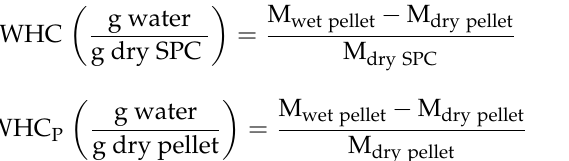
Table 1. Sample preparation to obtain the soy protein concentrate (SPC) samples with 6, 9, and 15 wt% protein concentrations.